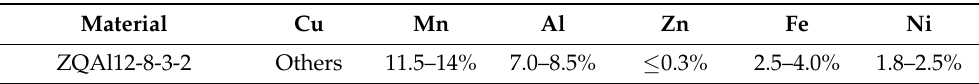
Table 1. The chemical composition of ZQAl12-8-3-2 copper